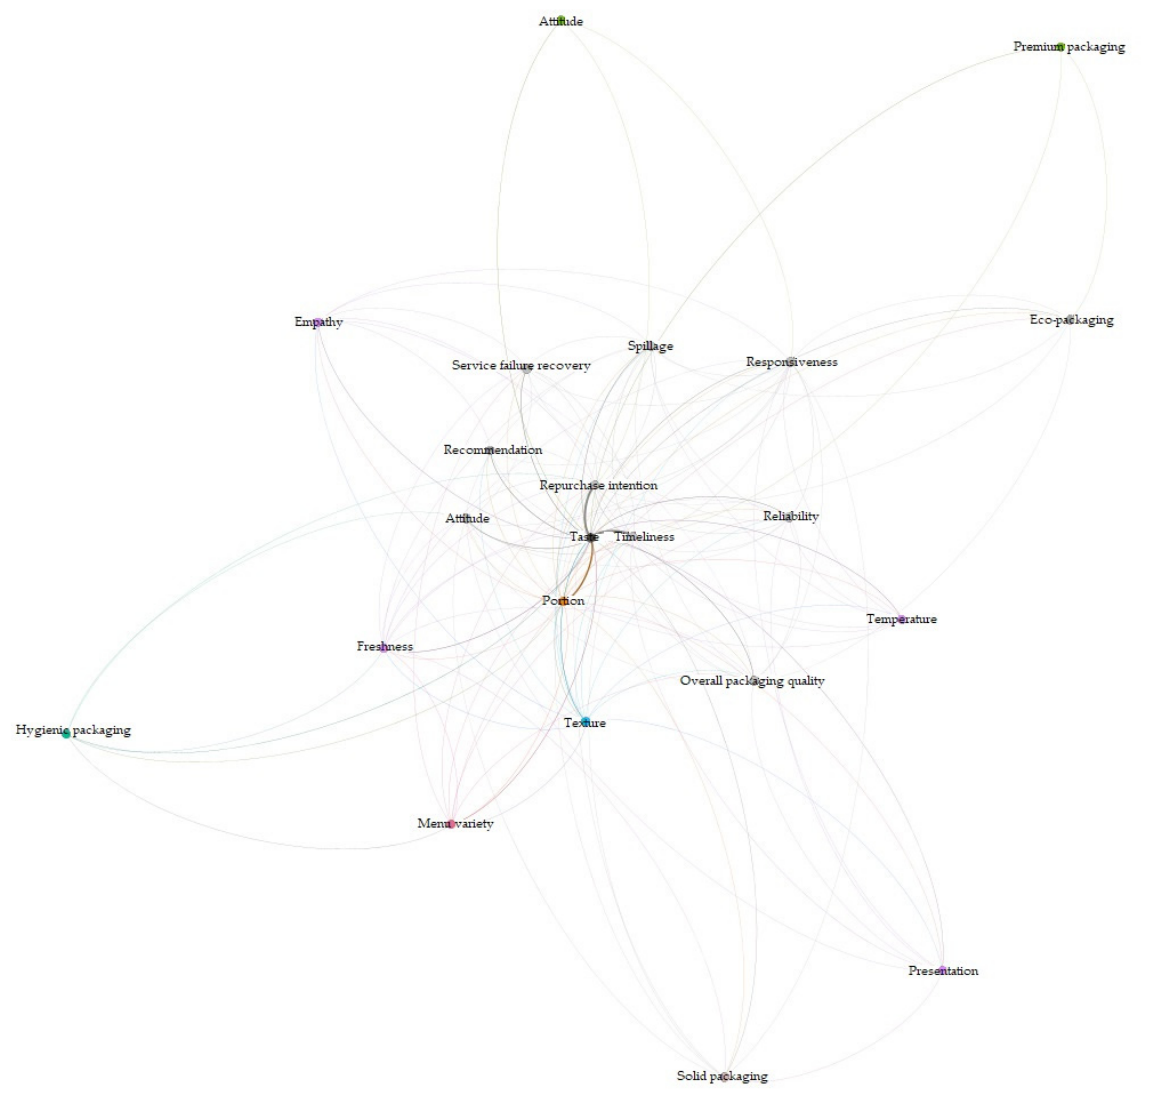
Figure 2. Network visualization of customer comments on Aomi (after COVID-19).